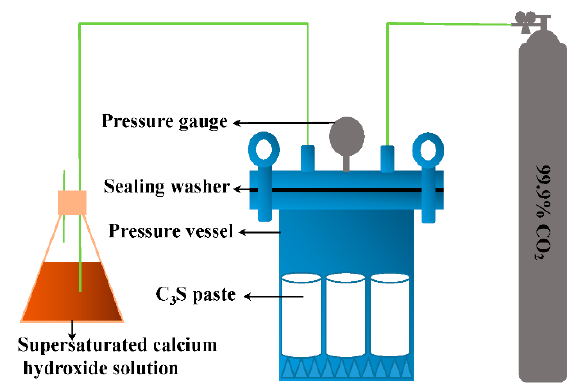
Figure 4. Schematic diagram of the carbonation curing setup.